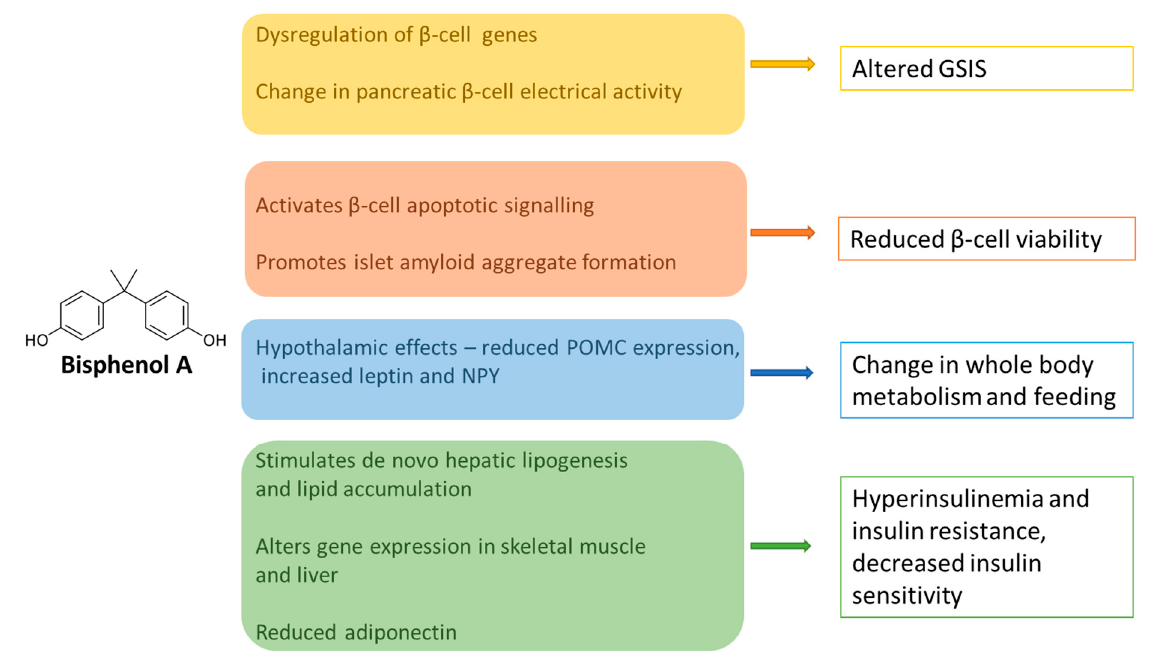
Figure 2. Diagram summarizing the key pathophysiological mechanisms linking BPA to T2DM. BPA acts in pleiotropic ways to impact on the main tissues that regulate glucose homeostasis. In the pancreas, it can modulate insulin production positively or negatively to differentially alter the early and late phases of GSIS. BPA affects insulin sensitivity and insulin receptor signalling in the muscle and liver, increases de novo lipogenesis, reduces the release of adiponectin, and alters central feeding behaviour through multiple pathways. GSIS—glucose-stimulated insulin secretion. NPY—neuropeptide Y. POMC—proopiomelanocortin.